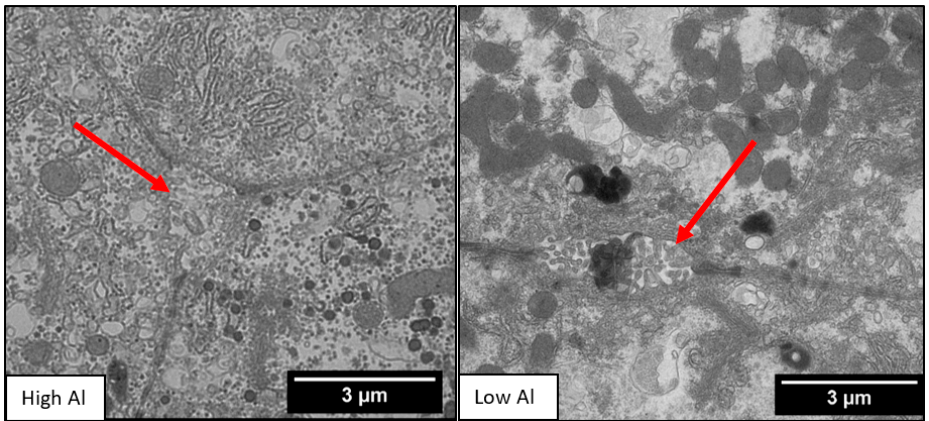
Figure 2. Mean microvillus height: canaliculi and space of Disse.